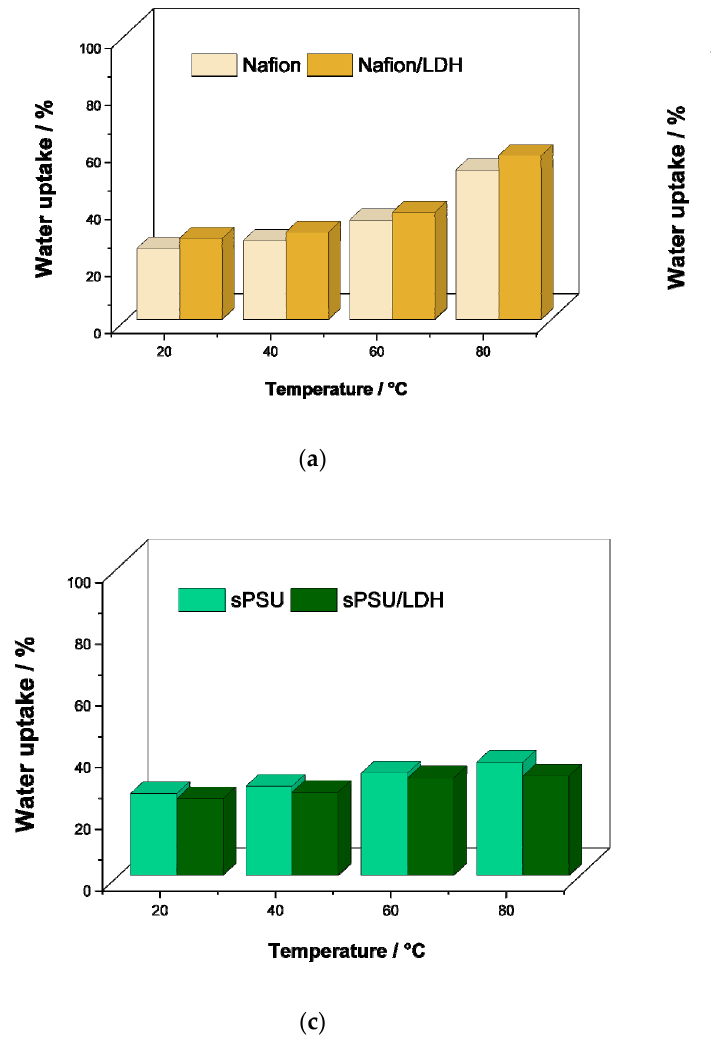
Figure 4. Temperature evolution of water uptake for ( a ) Nafion-based, ( b ) sPEEK-based and ( c ) sPSU-based membranes.